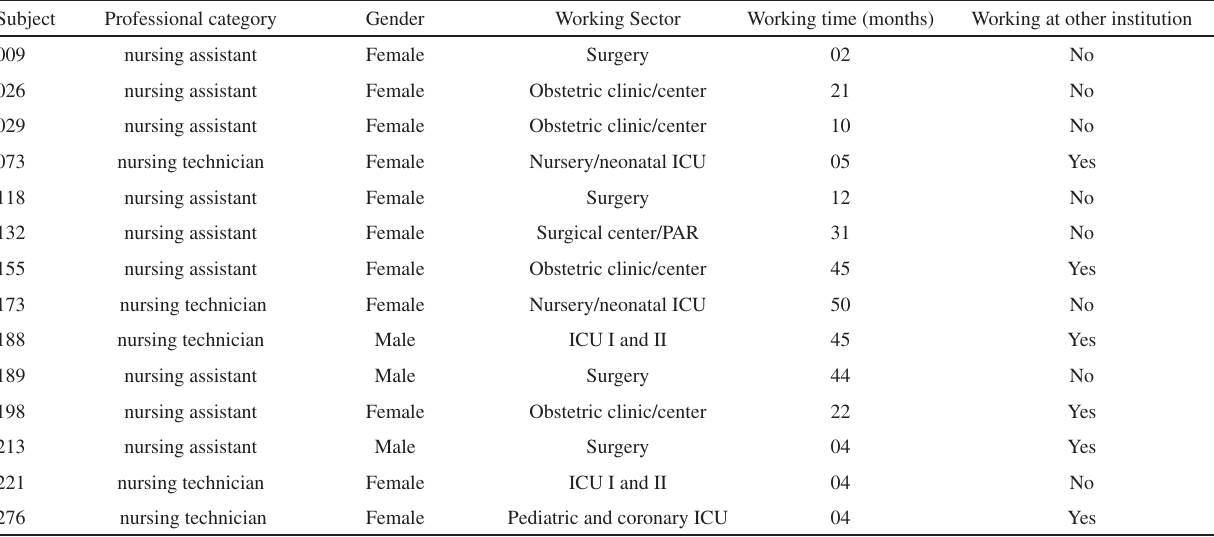
Table 5. This table indicates resistance to oxacillin as well as penicillin (100%). A total of 92.9% presented resistance to erythromycin, 57.1% to clindamycin,